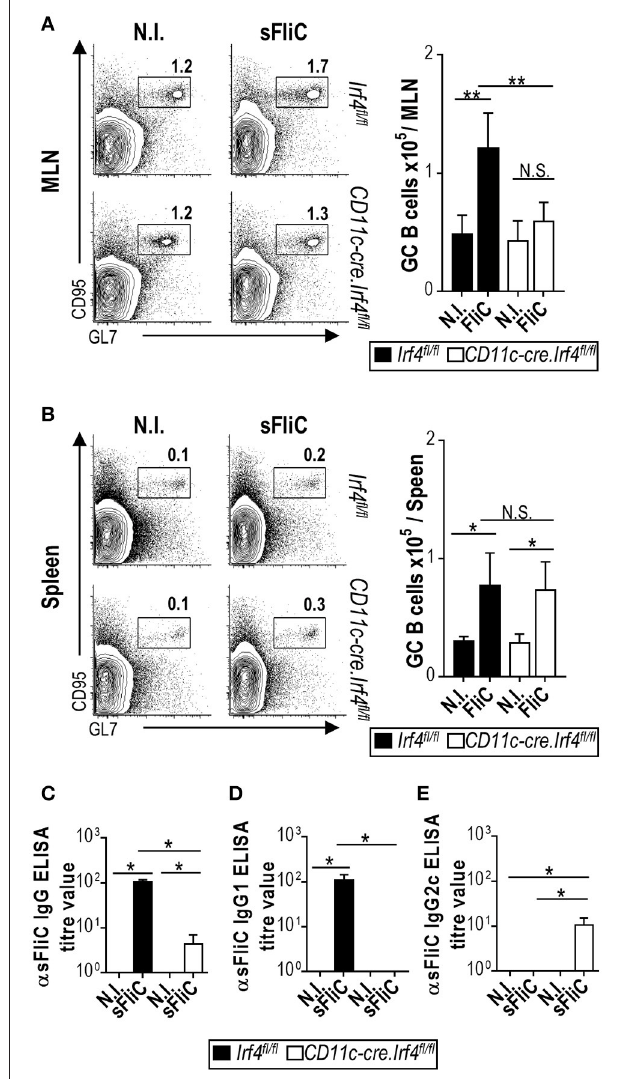
FIGURE 3 | The generation of primary B cell responses to sFliC in the MLN, but not the spleen, are dependent upon CD103 + cDC2. Irf4 fl / fl or Cd11c-cre.Irf4 fl / fl mice were either non-immunized (N.I.) sFliC-immunized and GC B cells (TCR β − CD19 + GL7 + CD95 + ) were evaluated 7 days later. (A) MLN and (B) spleen representative flow cytometry plots (percentages) and absolute numbers (graphs) of GC B cells. Data are mean + s.d. ( n = 4 mice/group) representative experiment of 3 performed. ** P < 0.001; * P < 0.05, by two-way analysis of variance (ANOVA), NS, not significant. (C)